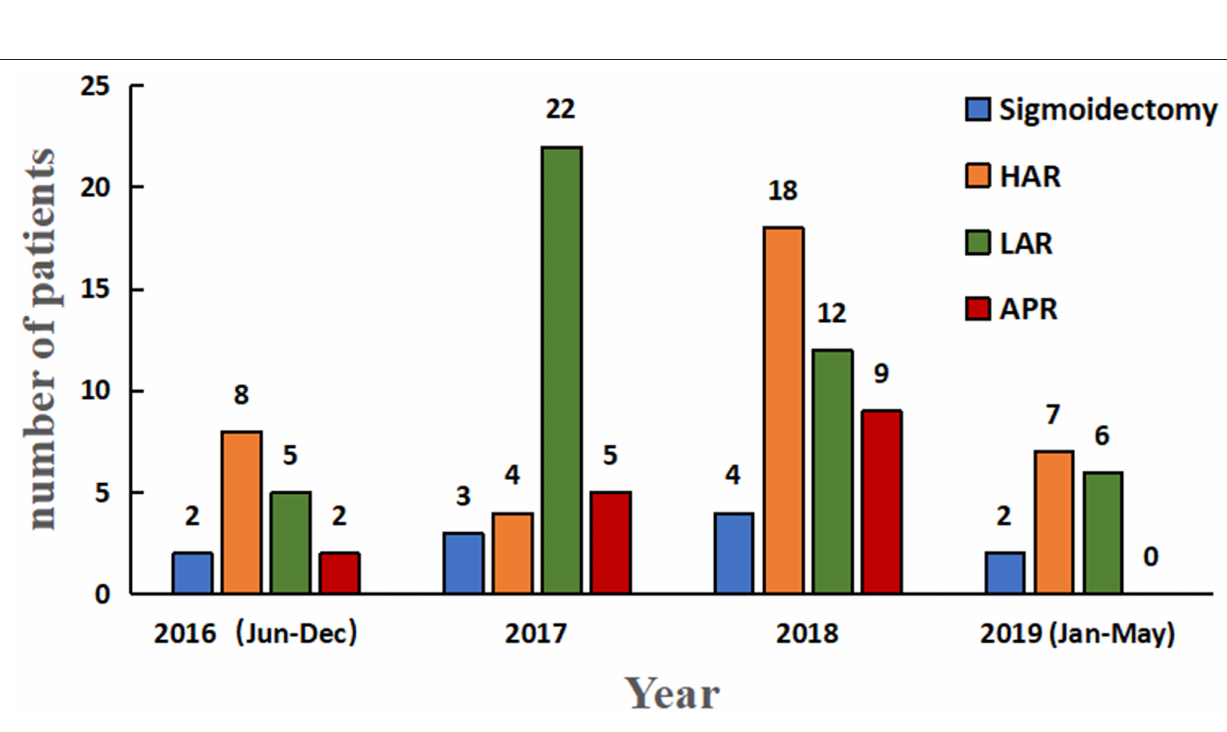
Frontiers in Surgery |